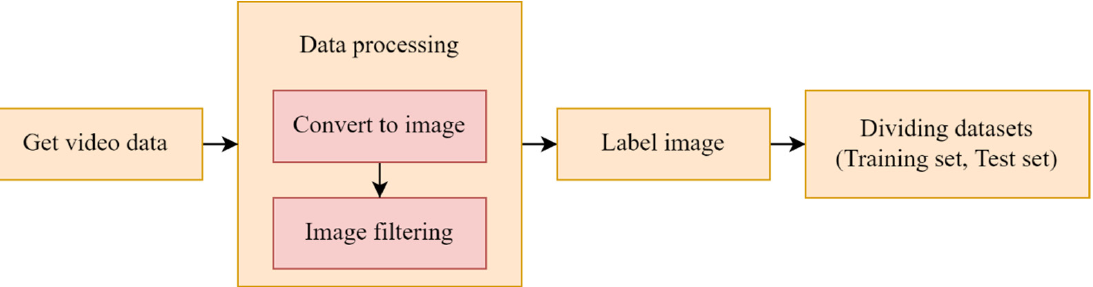
Figure 5. The dataset establishment process. (a) Obtaining video data